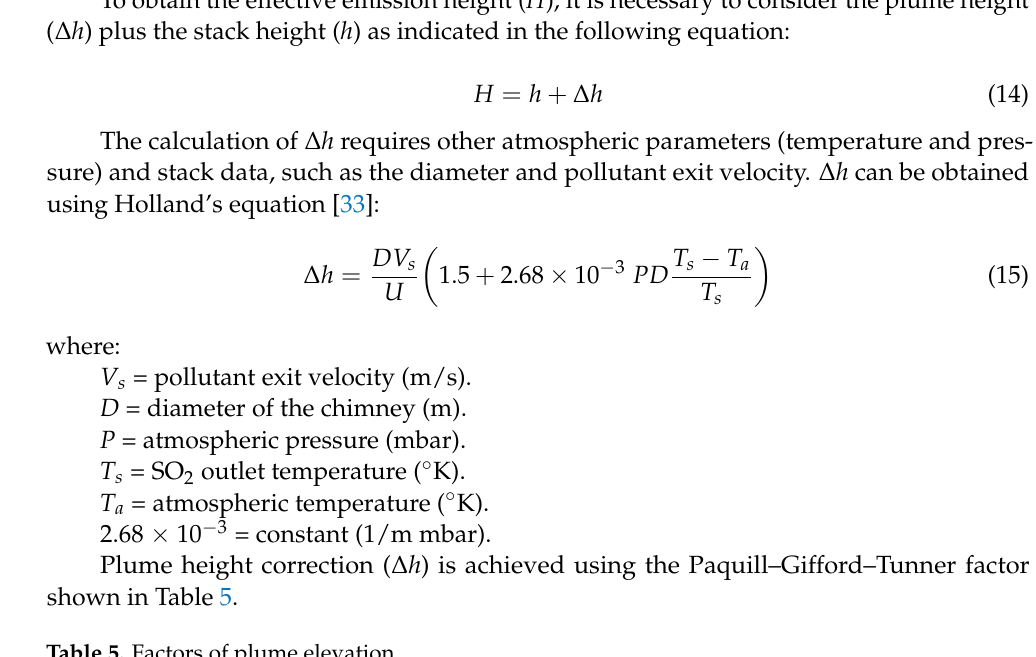
Table 5. Factors of plume